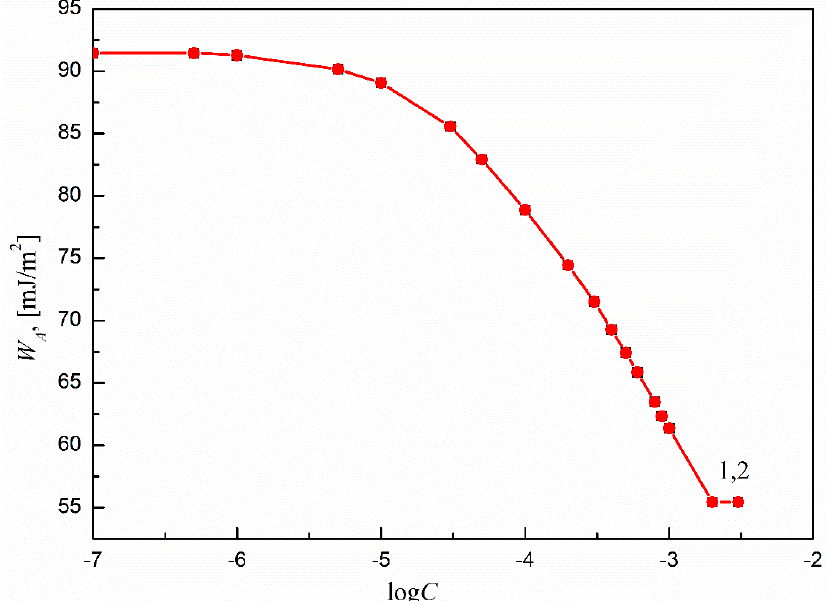
W ) of the aqueous solutions of SMD to Ti6Al4V ELI’s A